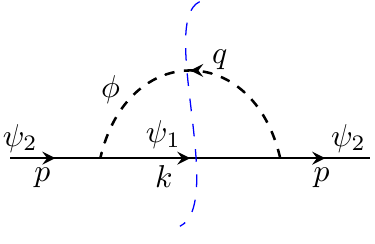
Figure 7 . The self-energy diagram of ψ 2 in the toy